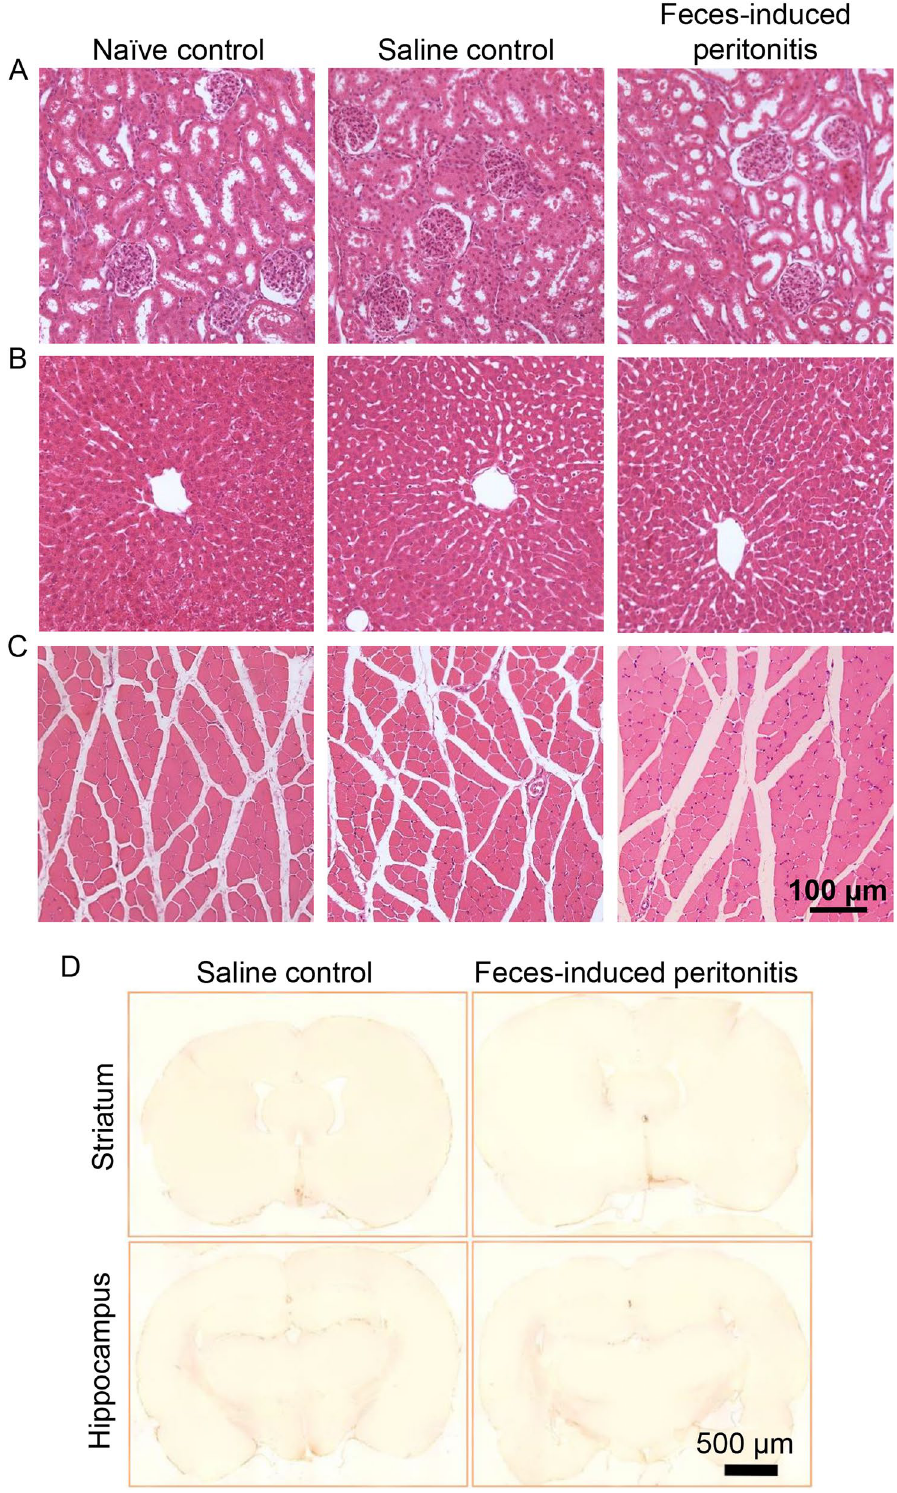
Figure 8. Histopathologic alterations and microglial activation were not observed in organs from rats at 6 h after induction of peritonitis. After completion of in vivo microscopy, rats underwent transaortic perfusion- fixation. Hematoxylin & eosin-stained cross-sections of the left kidney ( A ), liver ( B ) and left extensor digitorum longus ( C ) are shown. Naïve control animals were not subjected to intravital imaging. Coronal brain sections after staining with anti-MHC II antibody did not show microglial activation ( D ). Representative images from select areas of the brain are